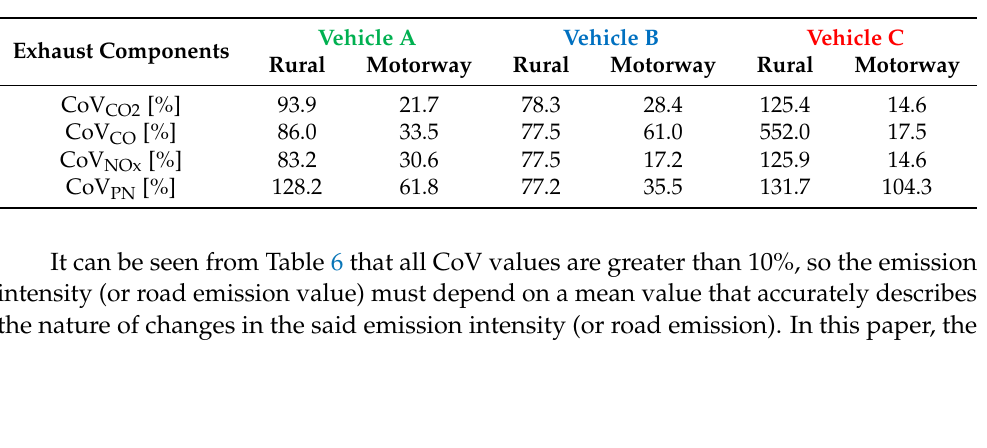
Table 6. CoV coefficient for all the tested exhaust